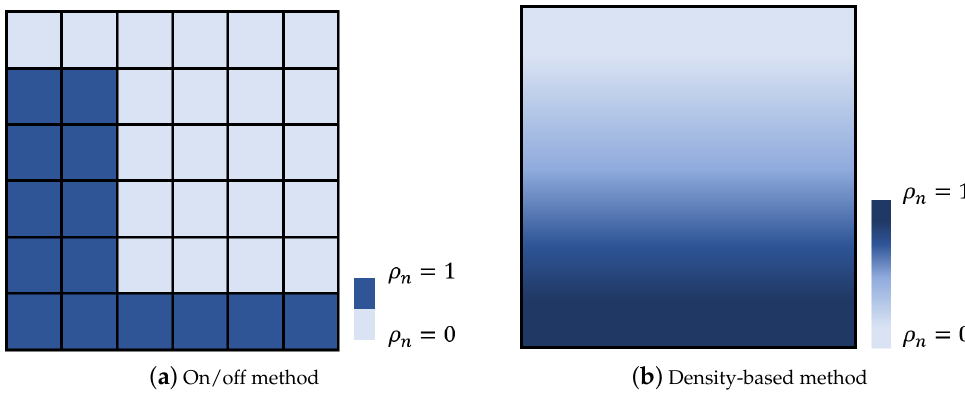
Figure 9. Illustrations of two topology optimization methods for magnetic cores. Here, ρ n is the normalized density variable under optimization.